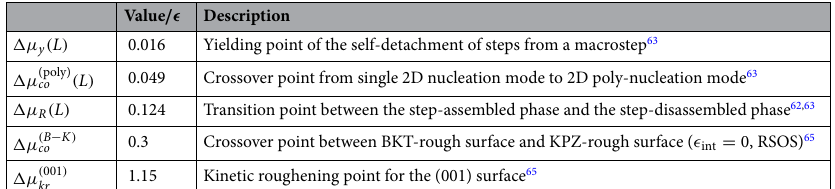
0.9. Surface slope = −